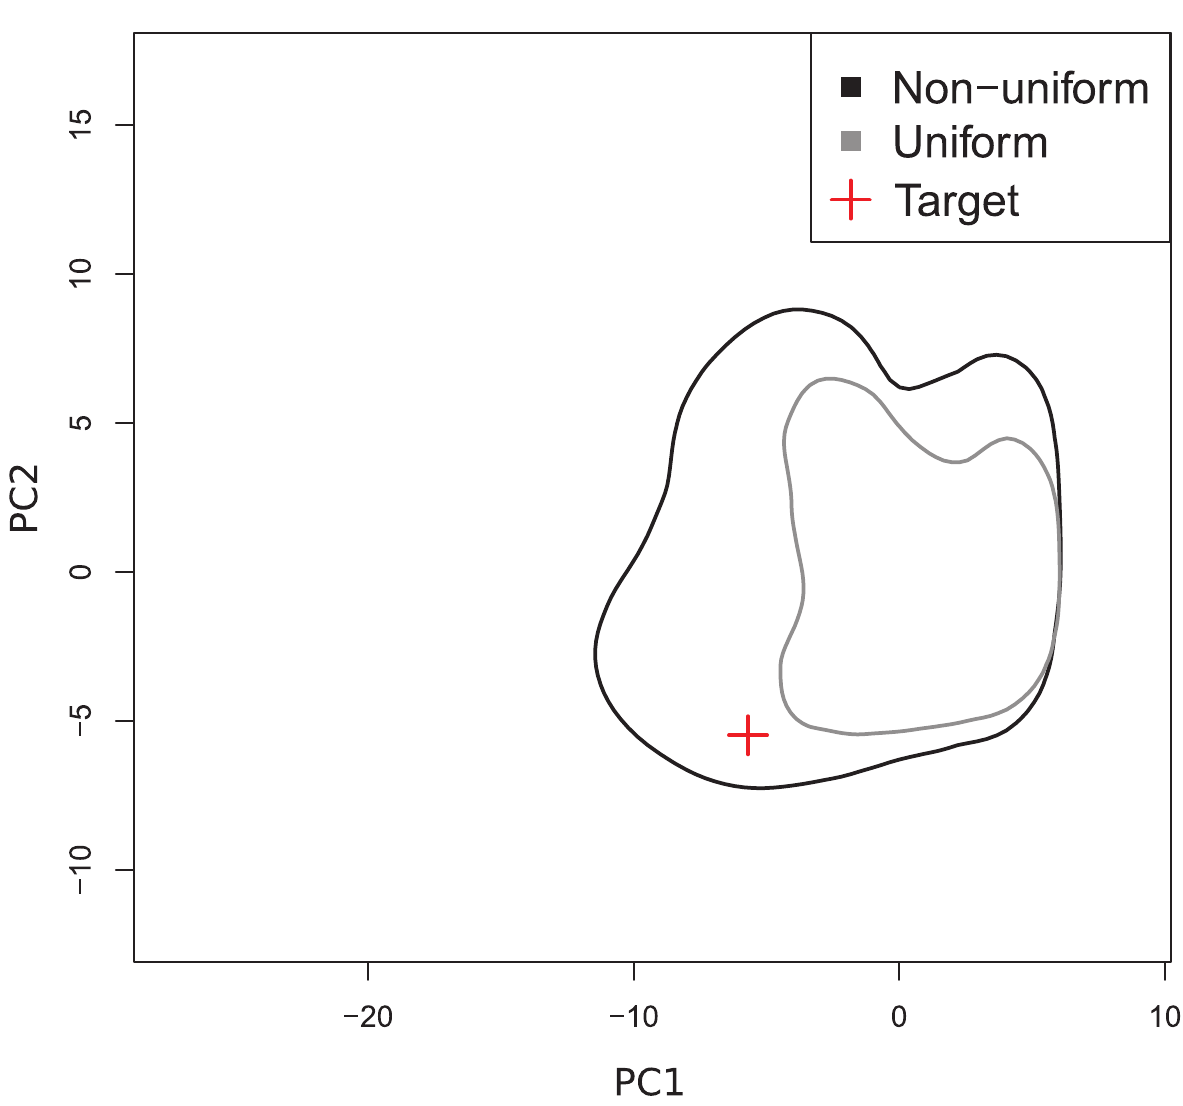
Fig 4. Goodness-of-fit estimated using parameter bootstrap. The graph displays envelopes containing 90% of the 10, 000 simulations for each distribution. The envelope in black results from the posterior distribution, in grey, results from the uniform distribution drawn from the 95% HPD distribution. The target data is represented by a red cross. Axes units are based on the outcome of principal component analysis using the simulated summary statistics.